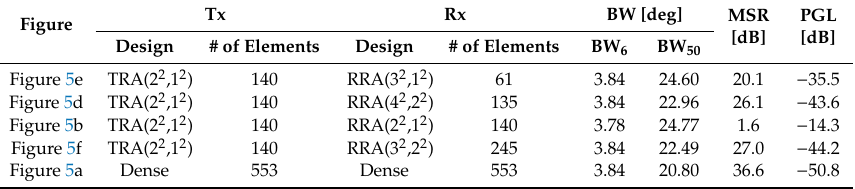
Table 1. Properties of near-field, pulsed-wave responses of rectangular array pairs.